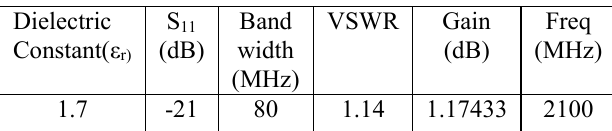
Table 1.3 Analysis of different parameters for Antenna